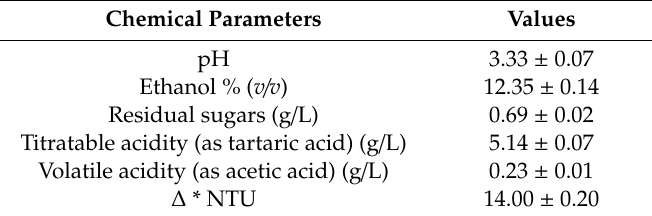
Table 1. Main analytical parameters of the Vernaccia wine used in the present